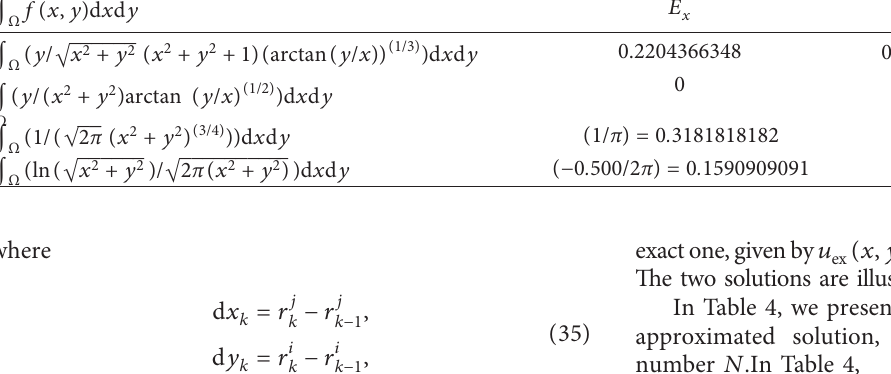
Table 2: Comparison between numerical integration using the δ ( 1/2 π ) 􏽒 f ( x, y ) d x d y Error Ω